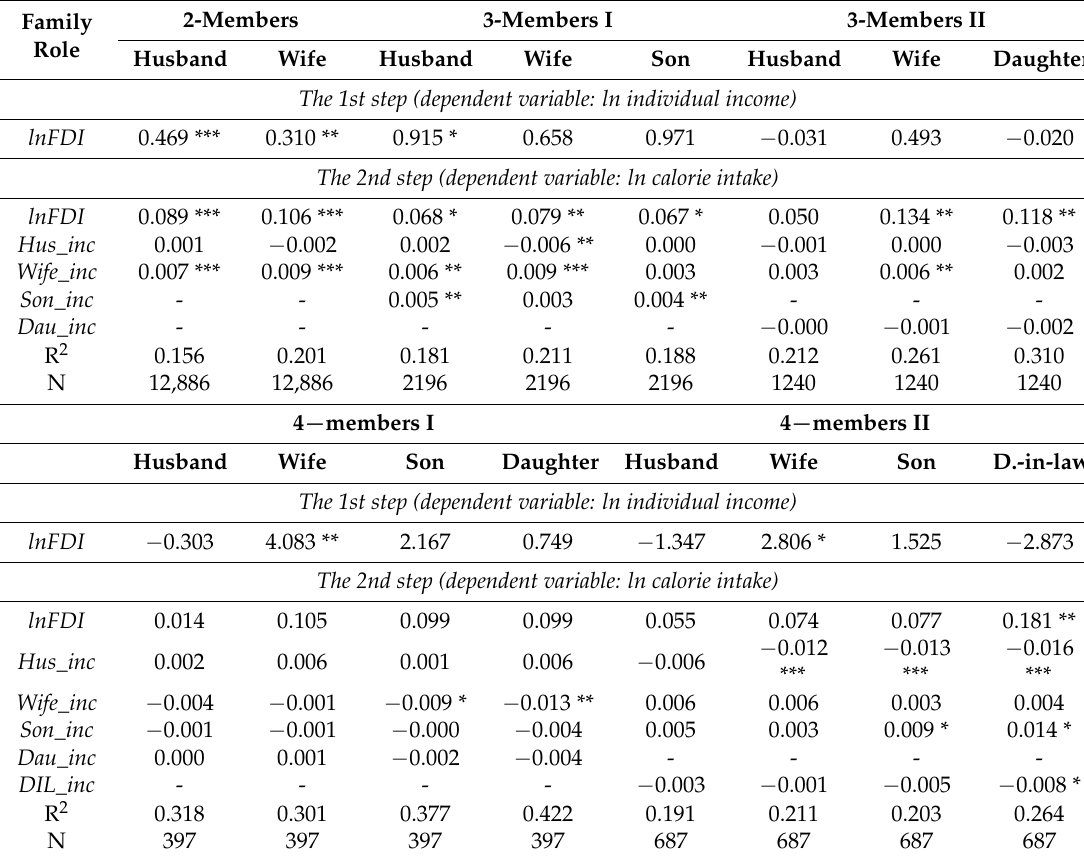
Table 7. Rural multiple adult members’ individual income